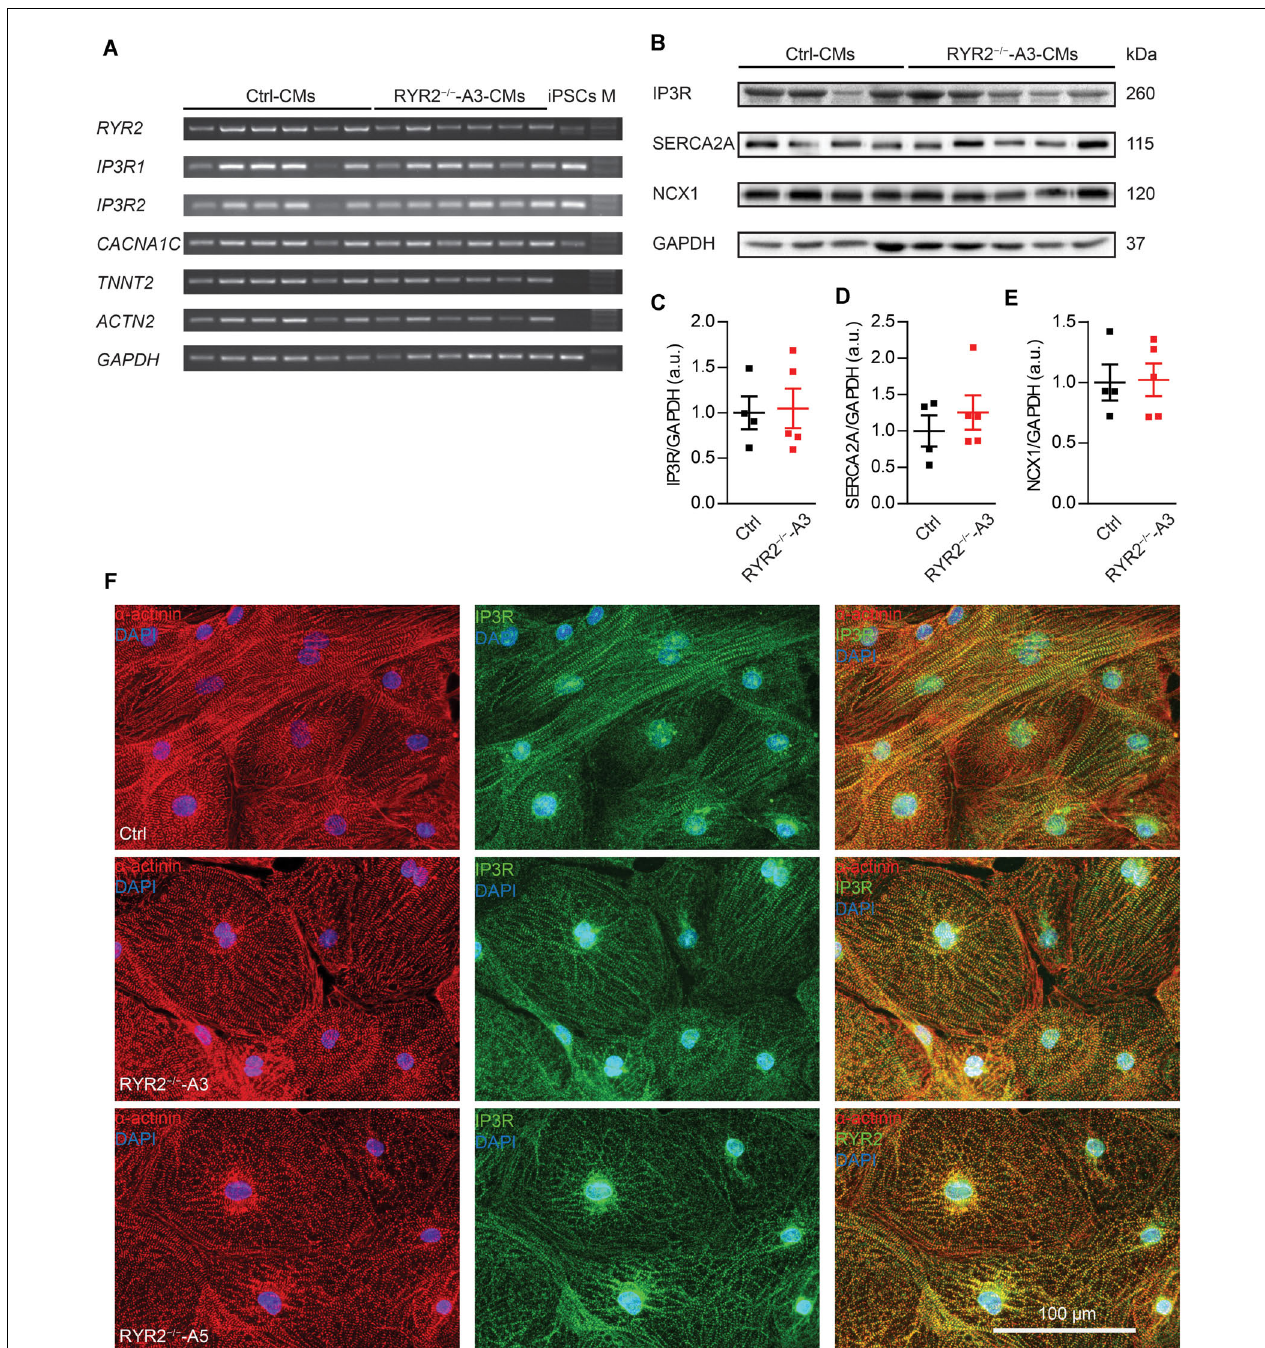
FIGURE 4 | Expression of markers involved in Ca 2 + signaling in RYR2 − / − -iPSC-CMs compared to Ctrl-iPSC-CMs. (A) Reverse transcription-PCR analyses showing mRNA expression of transcripts for Ca 2 + handling-related genes ( RYR2, IP3R1, IP3R2, and CACNA1C ), genes encoding sarcomeric proteins ( TNNT2 and ACTN2 ), and the housekeeping gene GAPDH in Ctrl- and A3 RYR2 − / − -iPSC-CMs (Ctrl: n = 6 and RYR2 − / − -A3: n = 6 different differentiation experiments). M: DNA molecular-weight size marker. (B) Western blot showing expression of Ca 2 + handling-associated proteins (IP3R, SERCA2A, and NCX1) in both Ctrl- and A3 RYR2 − / − -iPSC-CMs. (C–E) Scatter dot plot showing protein levels of IP3R (C) , SERCA2A (D) , and NCX1 (E) normalized to GAPDH between Ctrl- and A3 RYR2 − / − -iPSC-CMs (Ctrl: n = 4 and A3 RYR2 − / − : n = 5 different differentiation experiments). (F) Representative immunostaining of Ctrl- and RYR2 − / − -iPSC-CMs for IP3R (green) and α -actinin (red). Cells were counterstained with DAPI (blue). Scale bar, 100 µ m.